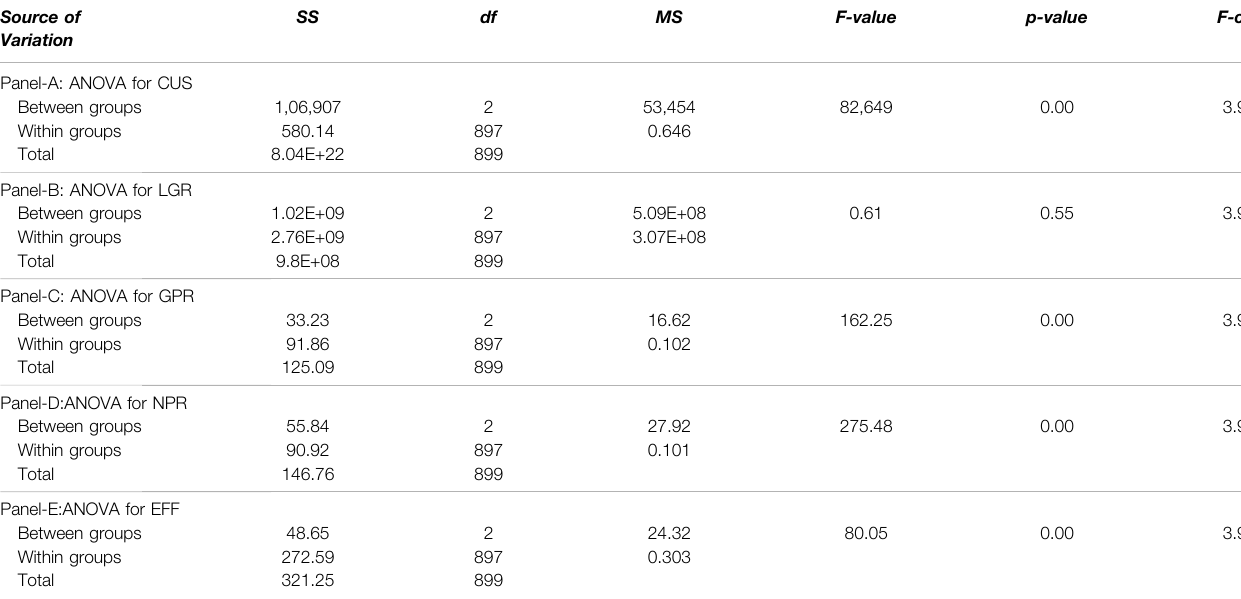
TABLE 1 | ANOVA for performance indicat. Source of Variation